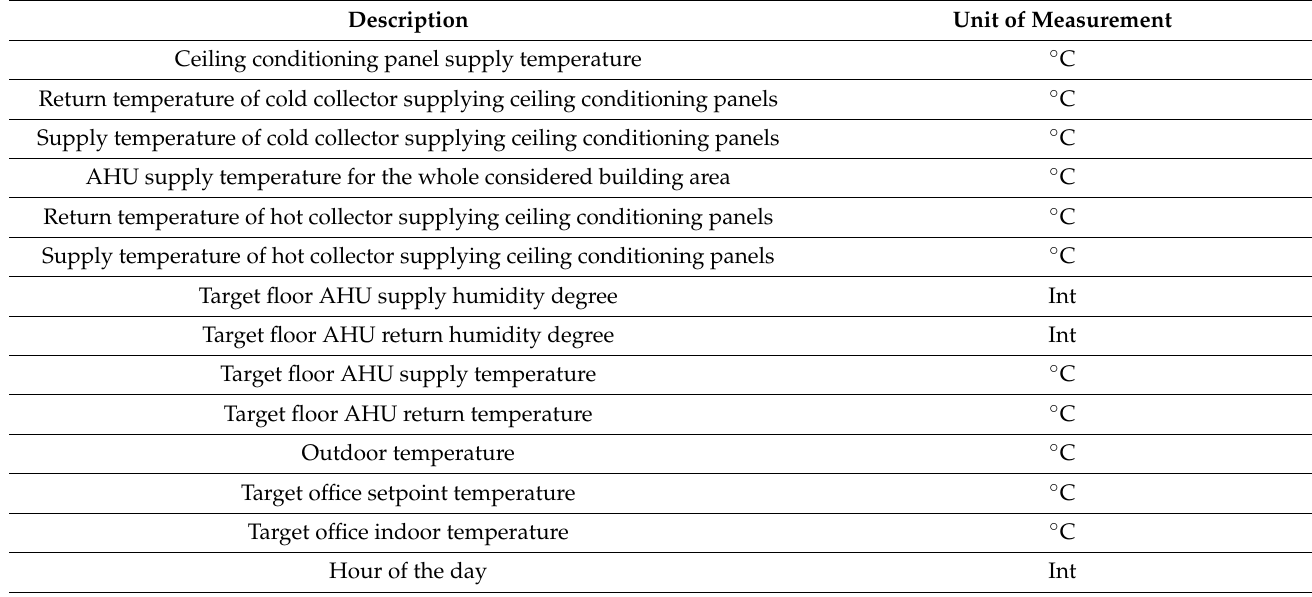
Figure 3. Correlation matrix between available features. The data pre-processing steps are summarised in Figure 4.